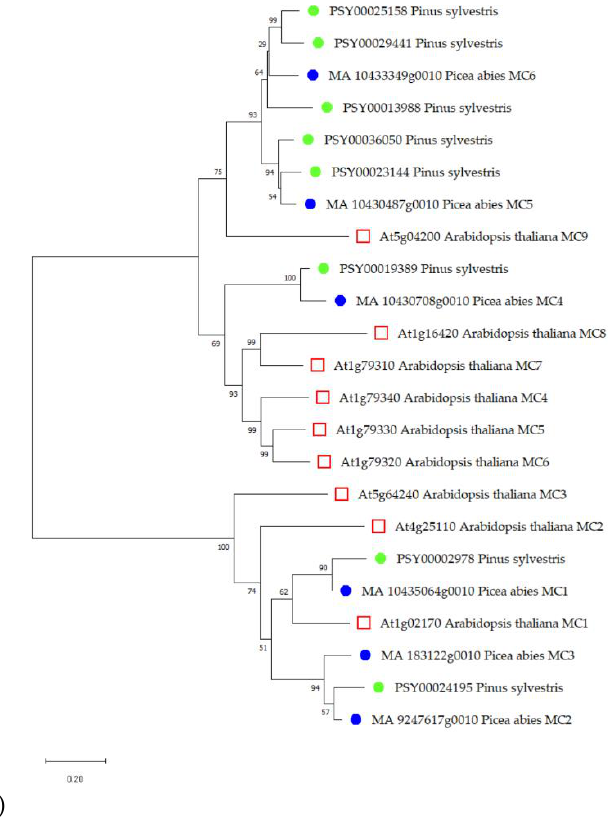
Figure 1. Maximum likelihood phylogenetic tree based on the nucleotide sequences of known genes from Arabidopsis thaliana L. (red squares), Picea abies L. (blue dots), and potential genes of Pinus sylvestris L. (green dots); ( a ) — bifunctional endonuclease ( BFN ); ( b ) — cysteine endopeptidase ( CEP) ; ( c ) — metacaspase ( MC ). The tree is drawn on a scale, with lengths of branches in the same units as the evolutionary distances used to infer the phylogenetic tree. The numbers shown next to the branches represent the results of the bootstrap test (1000 replicates). Along with the gene names are the database access codes: PLAZA ( P. sylvestris ), Congenie ( P. abies ), Phytozome ( A. thaliana ), and from Lim et al. [23] ( P. sylvestris BFN , TC 158725).